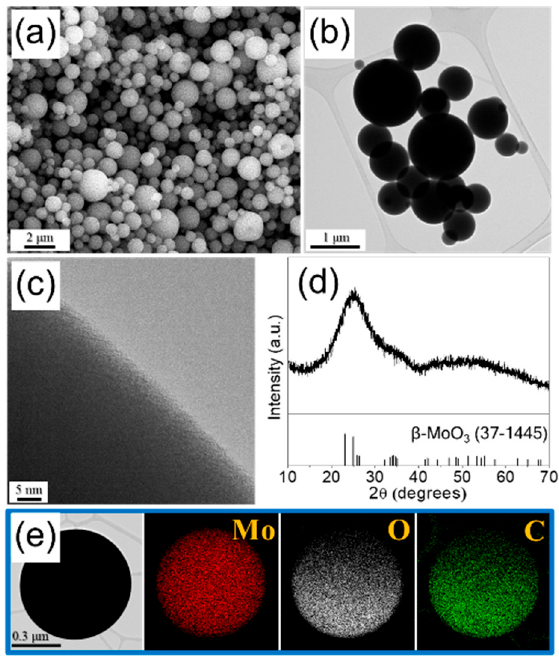
Figure 1. The ( a ) SEM, ( b ) TEM, ( c ) high-resolution TEM images, ( d ) XRD pattern, and ( e ) elemental mapping images of MoO 3 /C composite microspheres.